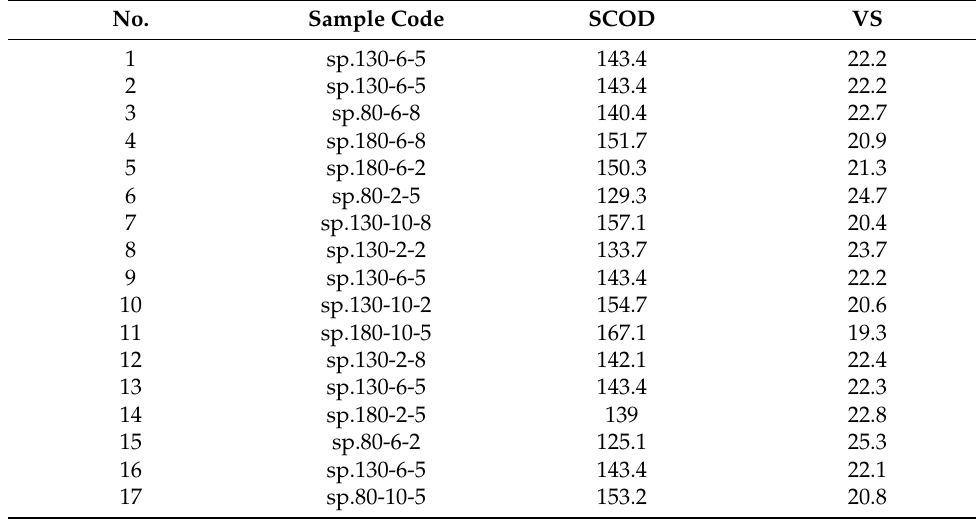
Table 2. SCOD and VS values after